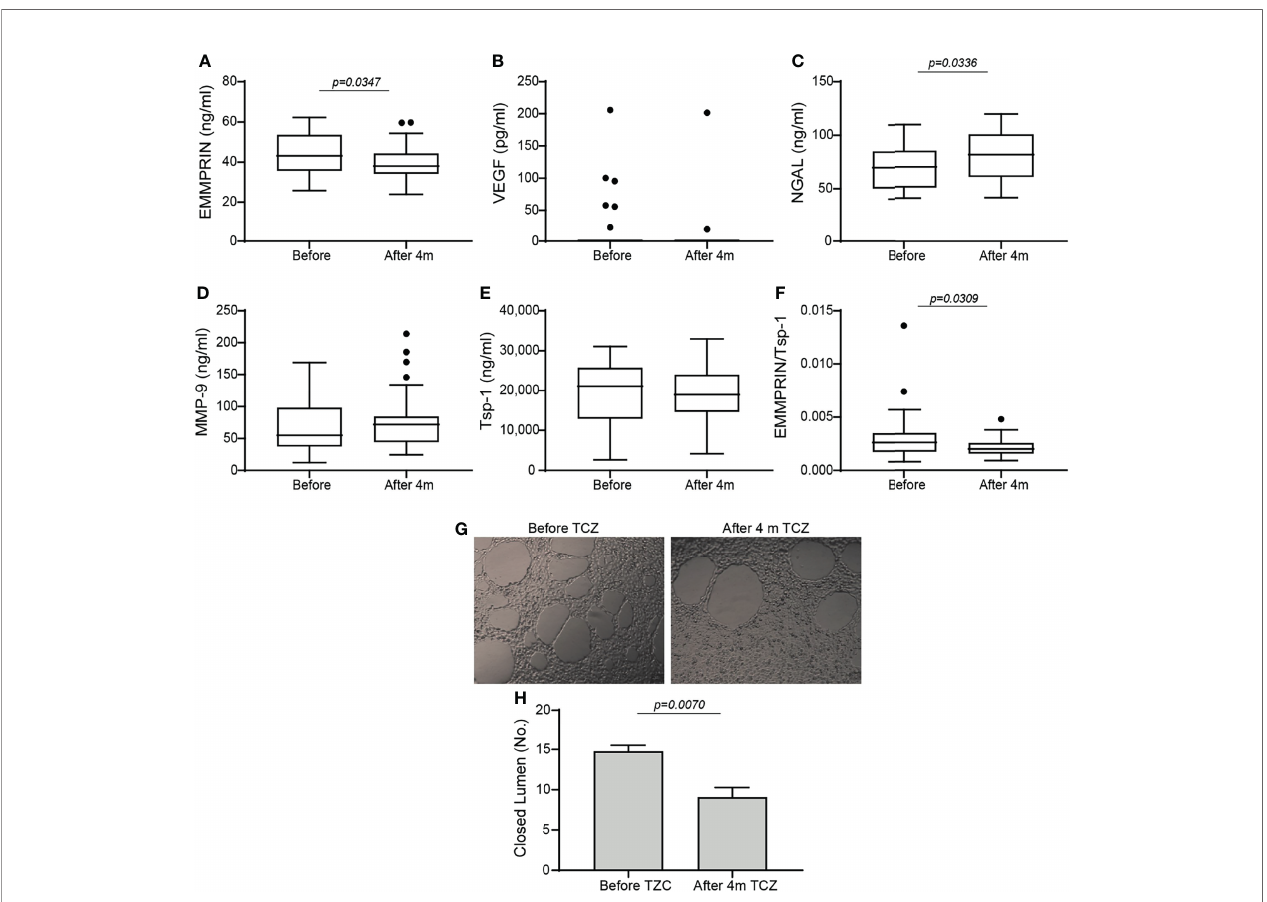
FIGURE 1 | Angiogenic factors in serum samples of RA patients before and 4 months after initiation of TCZ treatment. Box plot representing the concentrations of angiogenic mediators in the serum of RA patients before and 4 months after initiation of TCZ treatment, as determined in duplicates for each sample. (A) EMMPRIN, (B) VEGF, (C) NGAL, (D) MMP-9, (E) thrombospondin-1 (Tsp-1), and (F) the ratio between EMMPRIN and Tsp-1 as a suggested measure of enhanced angiogenesis. The non-parametric Mann-Whitney test was used to compare between the concentrations of each of the cytokines before and 4 months after TCZ treatment (n=40). (G) Tube formation assay with (H) closed lumen quantitation, to assess the direct angiogenic potential of serum samples on EaHy926 endothelial cell. The tube formation assay was carried out in triplicates with serum samples from selected patients, and the unpaired student t test was used to determine the effects of TCZ in the tube formation assay